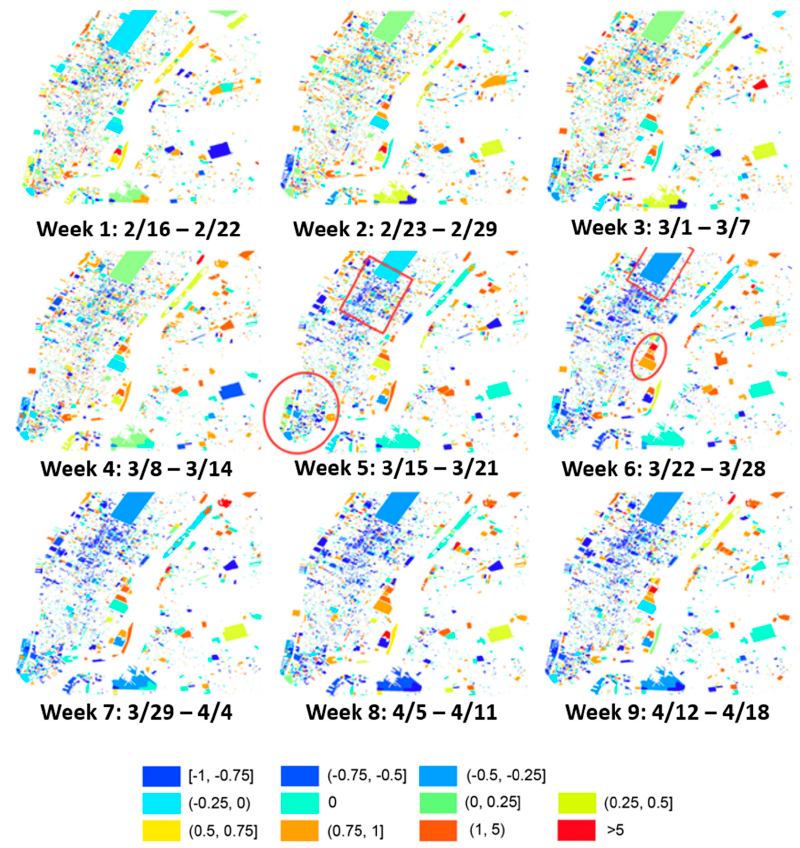
Figure 1. Human mobility changing patterns at parcel-level in week 1 – week 9. ISPRS Int. J. Geo-Inf. 2021 , 10 , x FOR PEER REVIEW